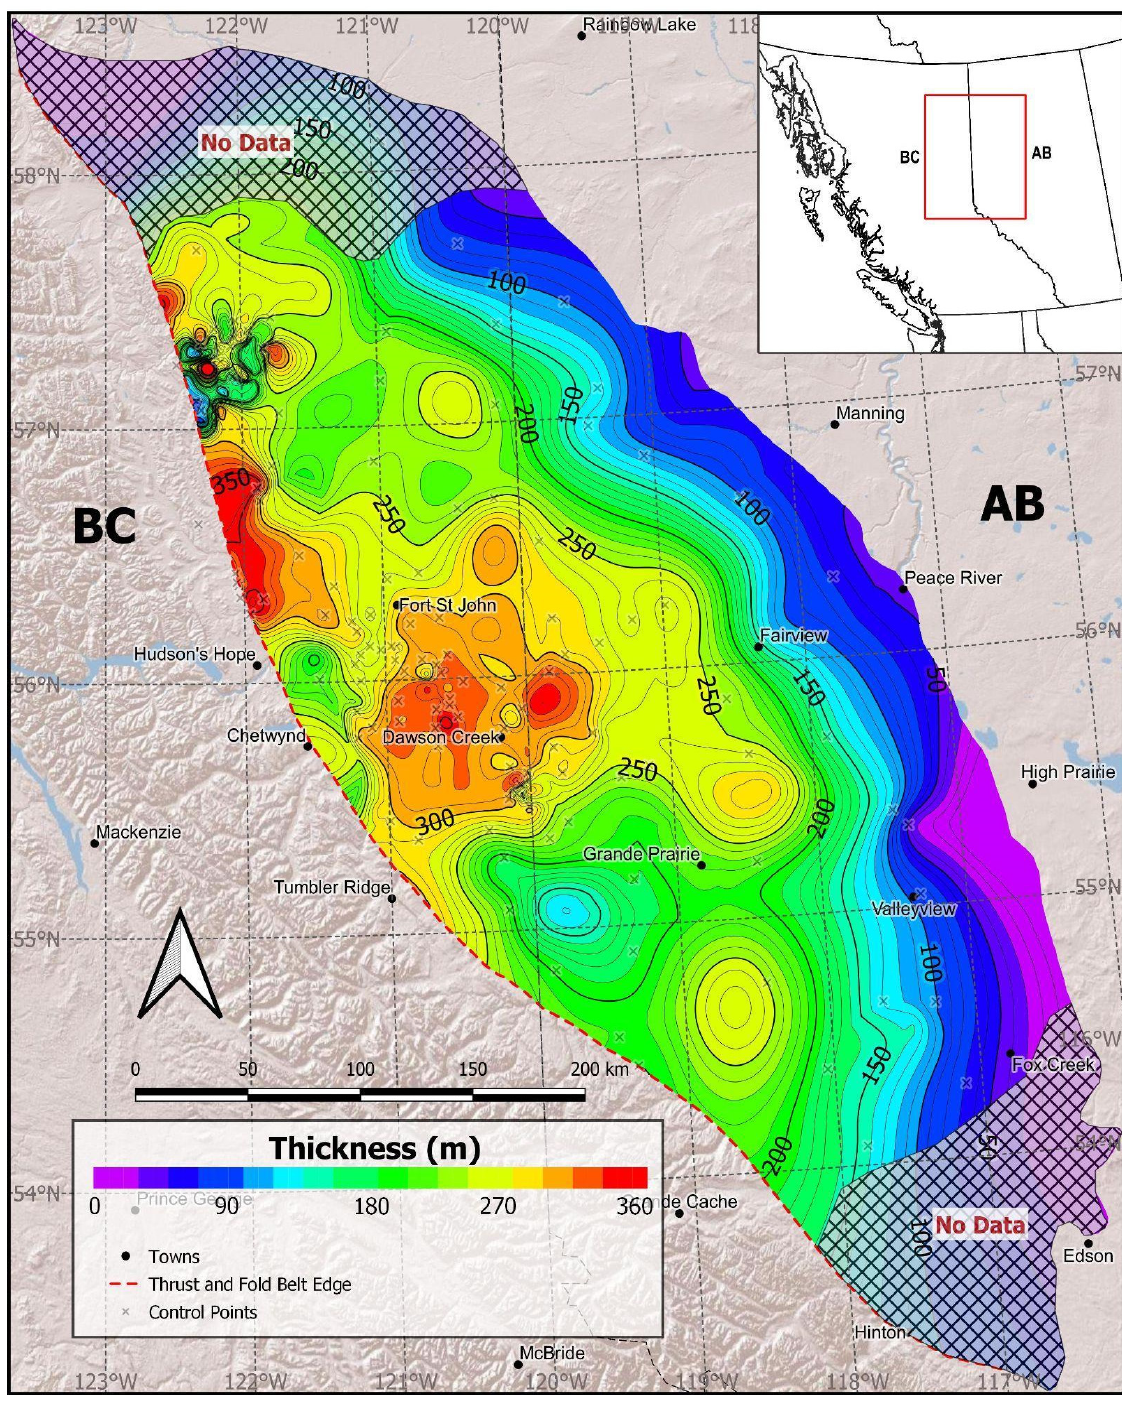
Figure 3. Thickness distribution of the Montney Formation British Columbia and Alberta. The impact of the Fort St. John Graben (see Figure 1) is shown by the localised thickening of the Montney Formation in the Fort St. John and Dawson Creek areas (red and orange shaded contours).